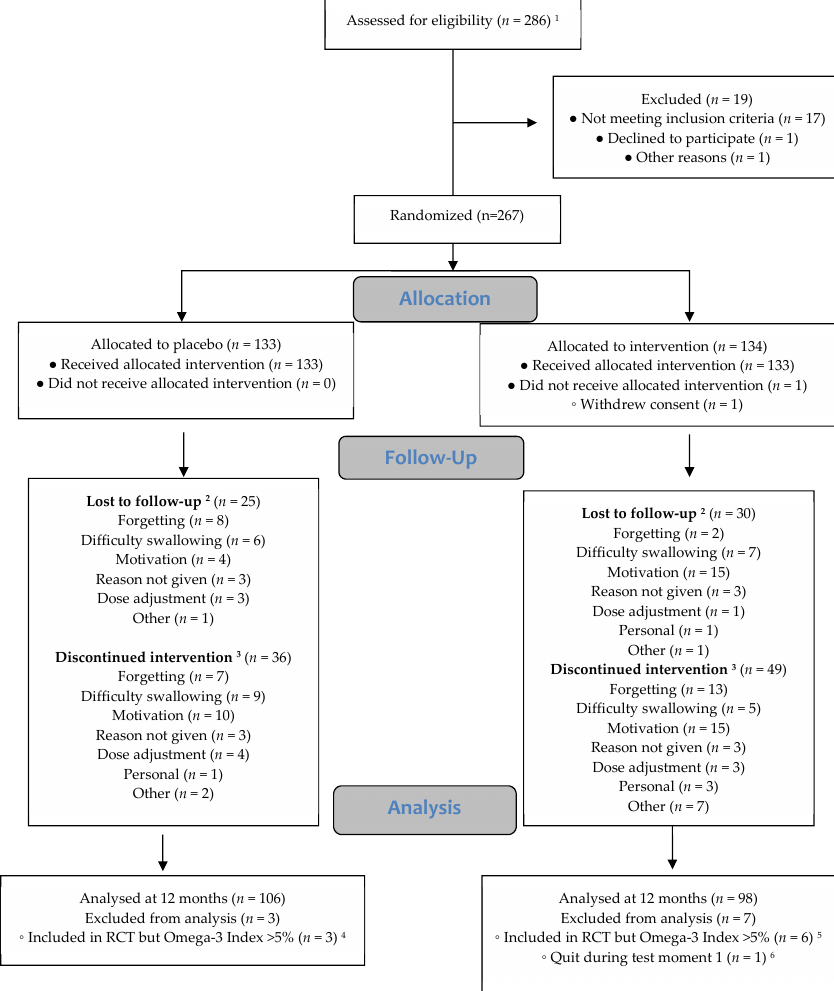
Figure 2. Flow chart. Flow chart adapted from Consort Guidelines [32] 1 Two additional participants provided consent, but then withdrew their consent again before blood sampling, these two participants are not included in this flowchart 2 Participants whom quite taking capsules and quite participation in testing. 3 Participants whom quite taking capsules but did participate in testing. 4 Three participants withan O3I > 5%were includedinthe placebogroupof theseone waslost tofollow up(reasonforgetting), one discontinued the intervention (reason dose adjustment) and one finished the intervention, they were all excluded from the analyses. 5 Six participants with an O3I > 5% were included in the intervention group of these one was lost to follow up (reason motivation), two discontinued the intervention (reason motivation / personal) and three finished the intervention, they were all excluded from the analyses. 6 This person is noted under lost to follow-up (reason